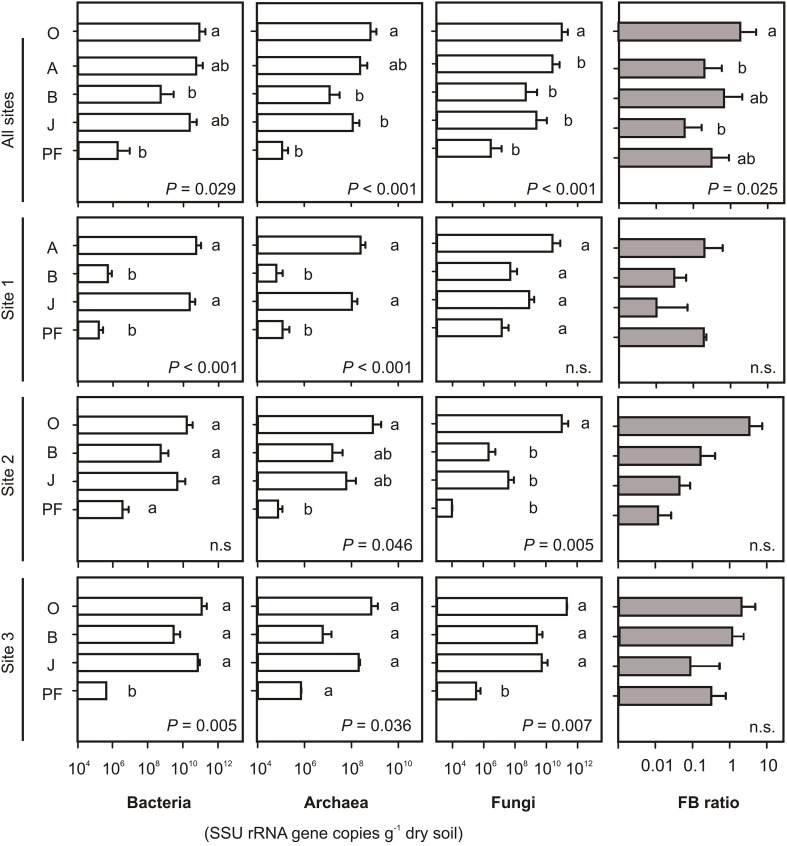
Abundances of Bacteria, Archaea and Fungi shown as bacterial, archaeal and fungal SSU rRNA gene copy numbers per gram dry soil and fungal-bacterial (FB) ratios. Note the difference in scaling of bacterial and fungal vs. archaeal abundances. Error bars for individual sites represent SD from 2 to 5 samples per soil type. Small letters indicate significant differences between soil horizons as determined by One-Way ANOVA and Tukey's HSD test. P-values indicate overall significant differences. O, organic topsoil; A, mineral topsoil; B, mineral subsoil; J, buried topsoil; PF, permafrost layer.